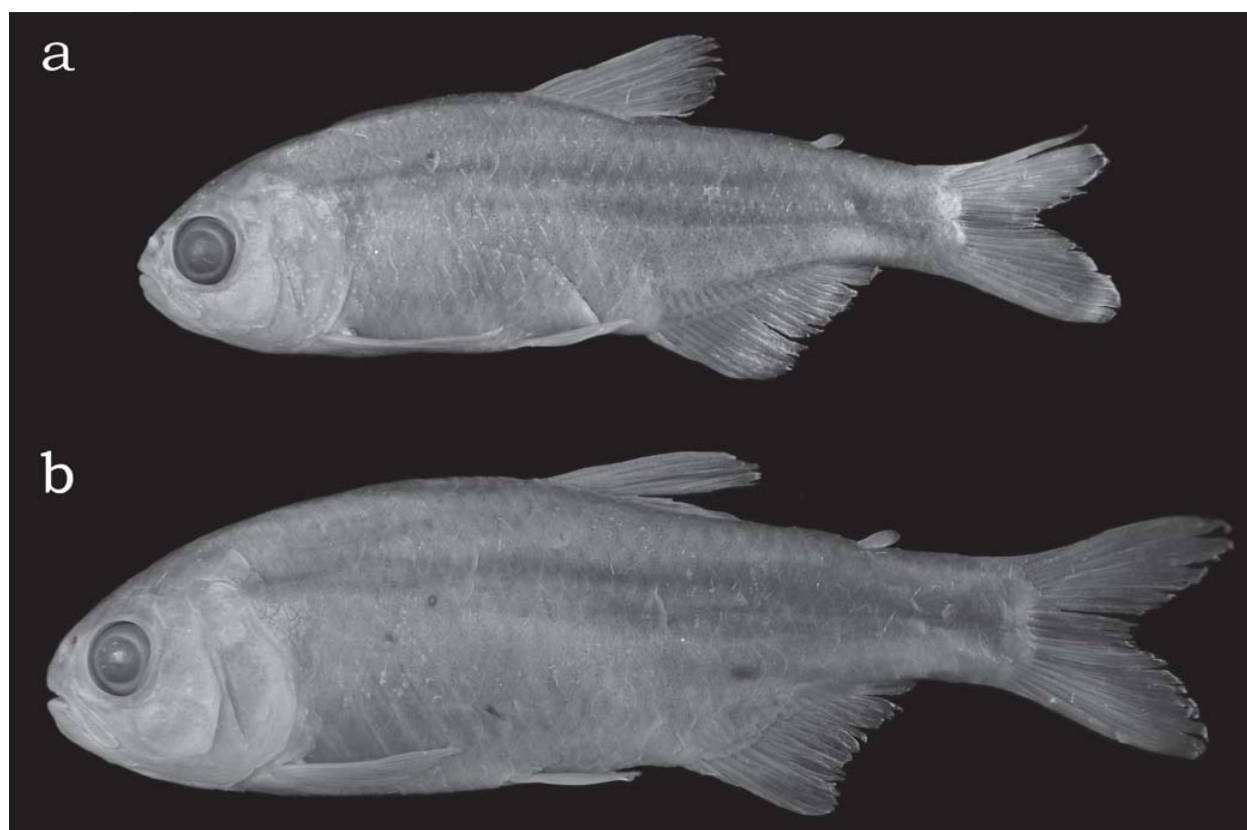
Fig. 1. Astyanax jordanensis , rio Jacu, rio Iguaçu basin, Candói, Paraná, Brazil. (a) MZUSP 99137, holotype, male, 47.7 mm SL. (b) NUP 1681, paratype, female, 56.7 mm